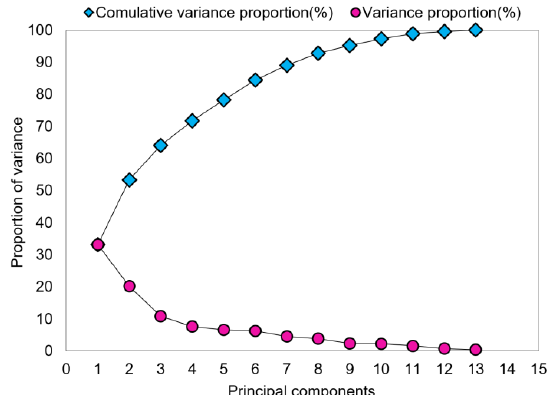
Figure 5. Proportion of variance explained by the number of principal components used. Table 3. Results of principal component analysis.